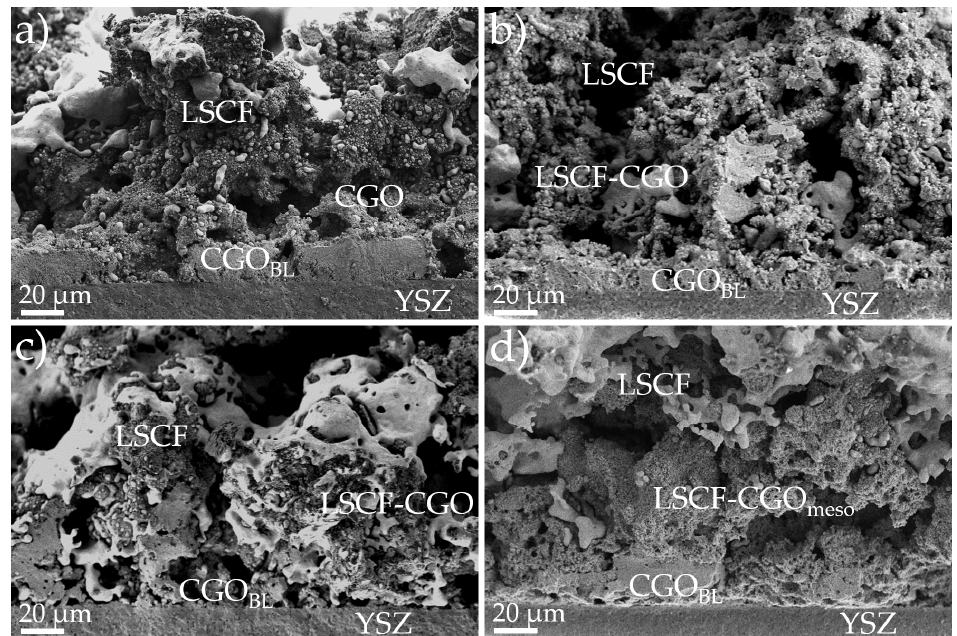
Figure 3. Cross-sectional SEM micrographs of the four different cells. ( a ) Micrograph of the CGO cell, fabricated with no infiltration. ( b ) Micrograph of the cell fabricated with slow infiltration and 5/20 sat. (5-CGO). ( c ) Micrograph of the cell fabricated with fast infiltration and 10/20 sat. (10-CGO). ( d ) Micrograph of the cell fabricated with a mesoporous CGO scaffold and fast infiltration (10-CGO meso ).